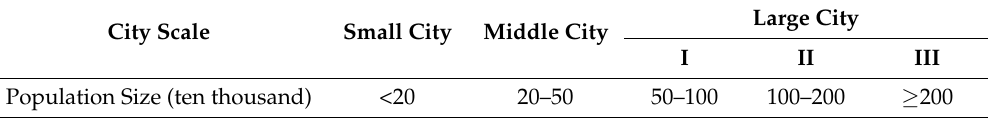
Table 2. The city scale standard.